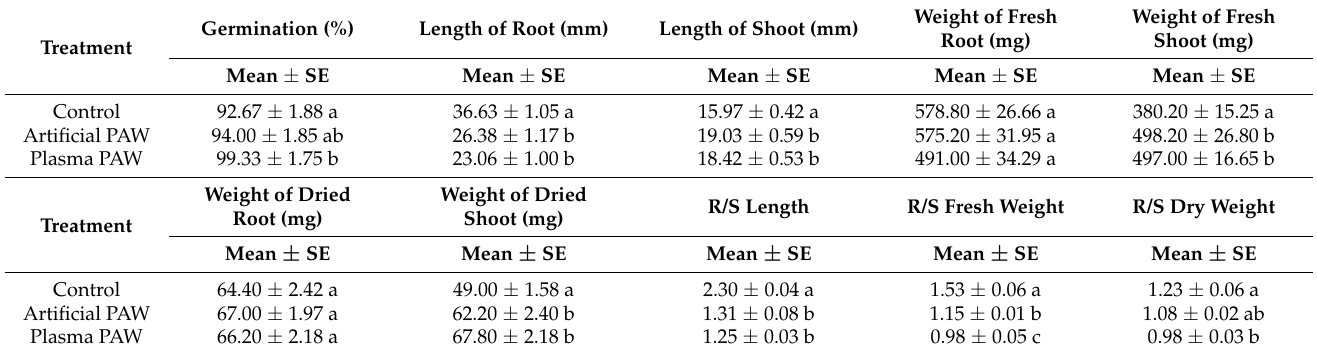
Table 1. Characteristics of seed germination and early growth of wheat grains after three types of treatment: water, artificial PAW, and plasma PAW. The mean, standard error (SE), and Tukey’s test results are given. Significant differences at p < 0.05 are indicated by different